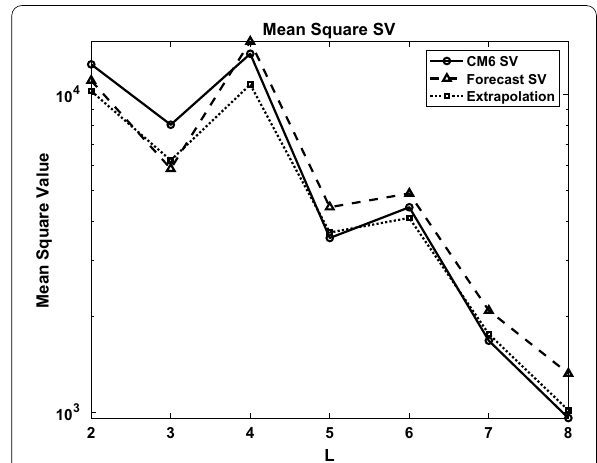
Fig. 3 Mean square SV 2009-2015 vs. harmonic degree for forecast (dashed line), CM6 (solid) and CM6 extrapolation from 2009-2010 (dotted)